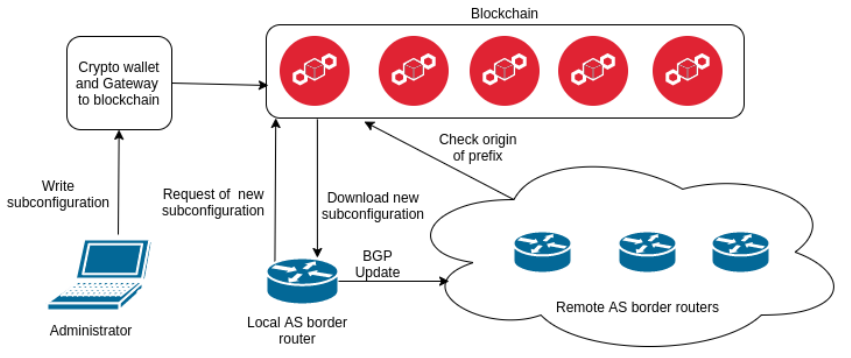
Figure 2. Design